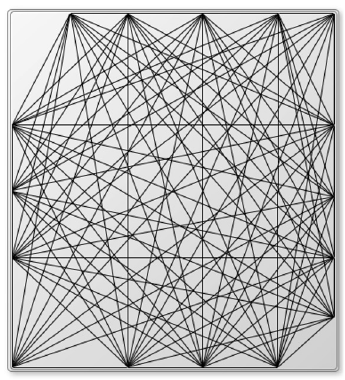
Figure 8. An example of the measurement grid formed by the tomography probes (16 devices) in a rectangular